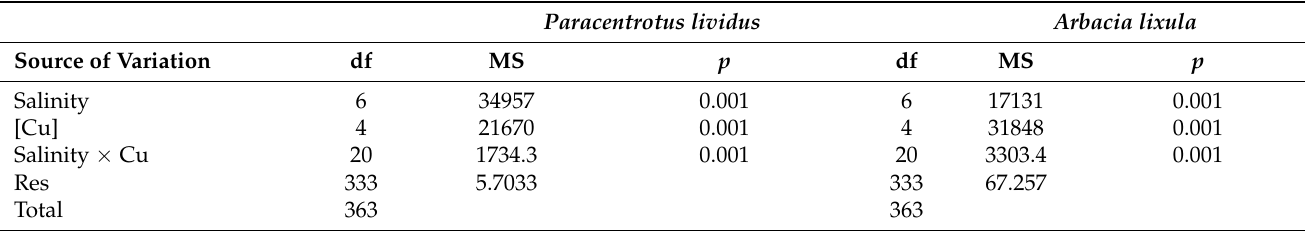
Table 1. Analysis of variance (two-way ANOVA) of embryo development in response to different salinities and copper concentrations. df: degrees of freedom, MS: mean squares, p : significance ( p < 0.01). Paracentrotus